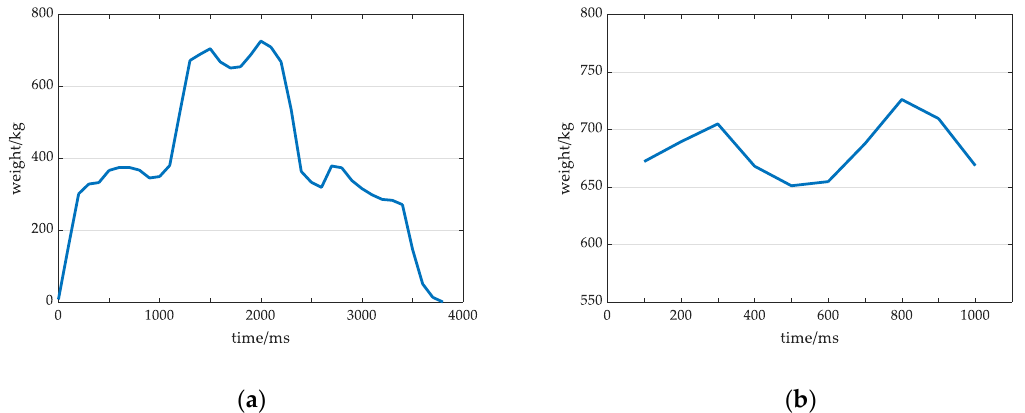
Figure 7. Original weight signal and valid signal in the high grade of active degree: ( a ) Original weight signal at a high grade; ( b ) Valid signal at a high grade.